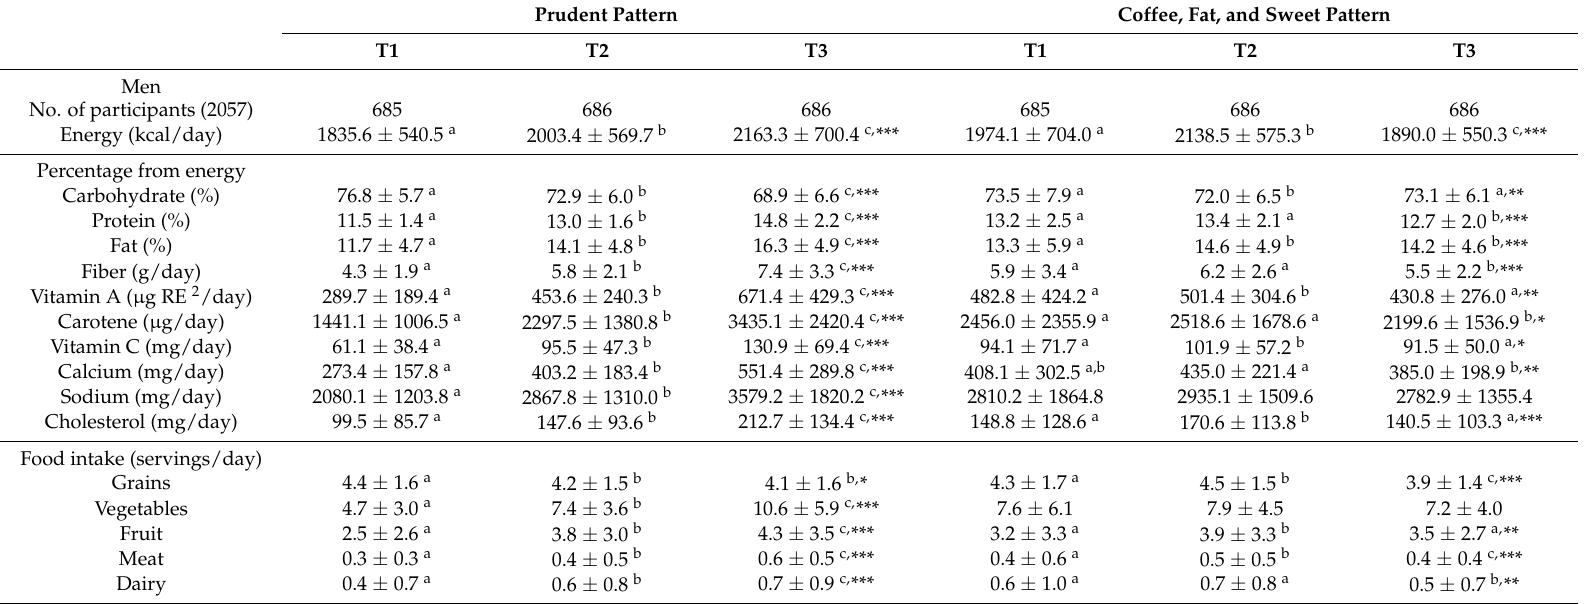
Table 5. Nutrient and food intakes of Korean in high low-density lipoprotein cholesterolemia analysis according to the tertile (T) categories of dietary pattern scores ( n = 4005) 1